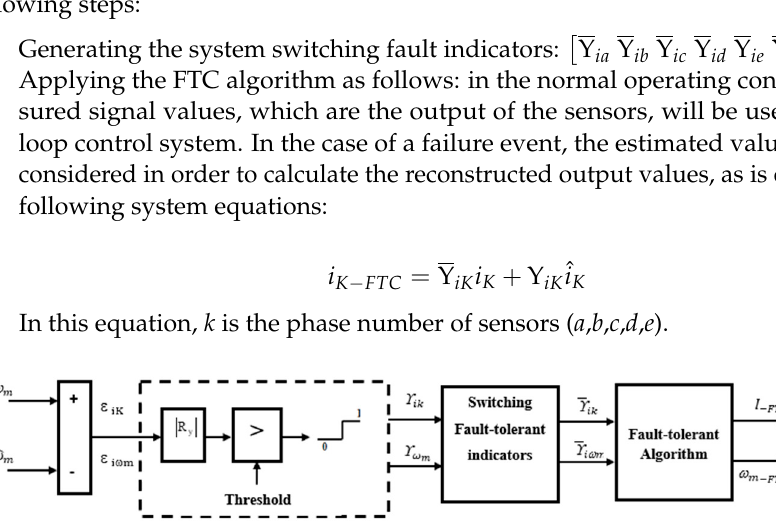
Figure 3. The proposed FTC scheme.